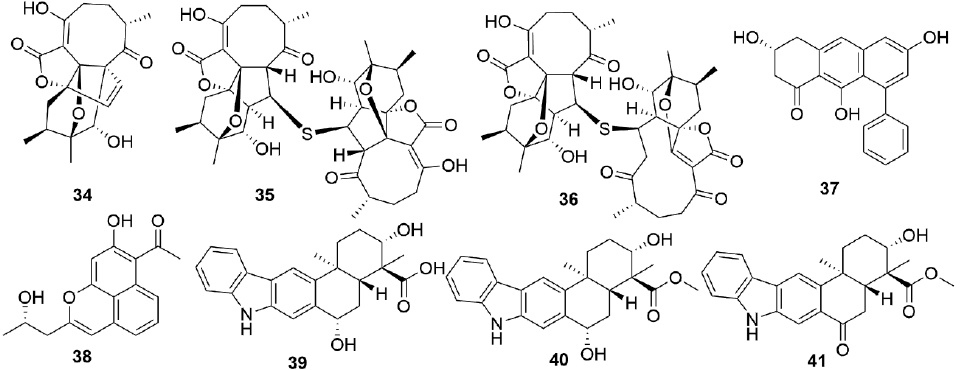
Figure 4. Examples of recently isolated natural products from marine bacteria with antiviral activity. Neoabyssomicin D ( 34 ). Neoabyssomicin F ( 35 ) and Neoabyssomicin E ( 36 ) are polycyclic polyketides isolated from S. koyangensis SCSIO 5802. Wailupemycin J ( 37 ) and ( R )-wailupemycin K ( 38 ) are phenolic polyketides isolated from Streptomyces sp. OUCMDZ-3434. Xiamycin C ( 39 ), Xiamycin D ( 40 )